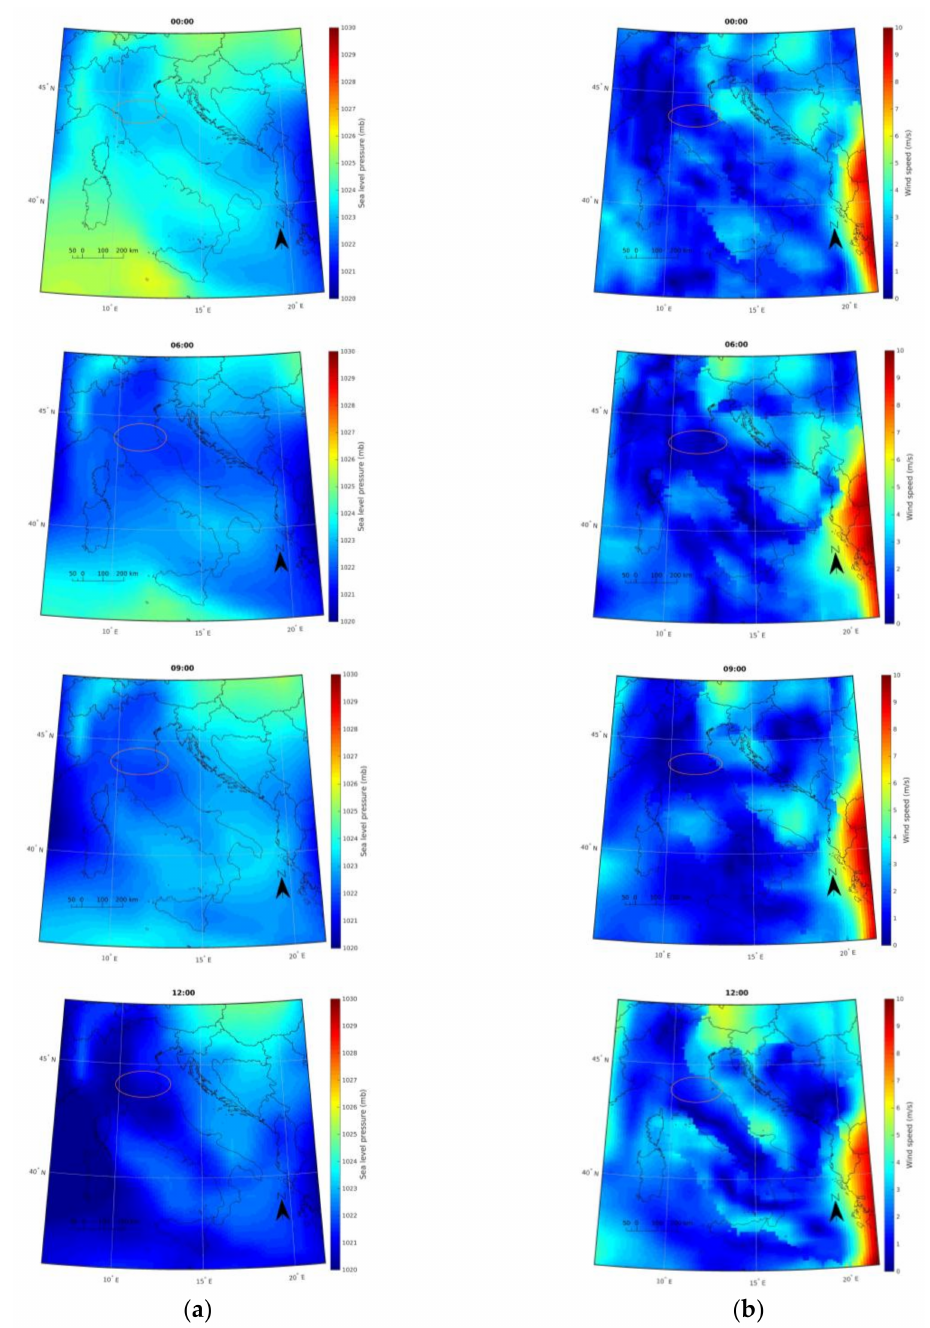
Figure 7. European Centre for Medium Range Weather Forecasts (ECMWF) reanalysis product for 2017-04-10 at 00:00, 06:00, 09:00 and 12:00 UTC: ( a ) Sea level pressure (mb); ( b ) Wind speed (ms − 1